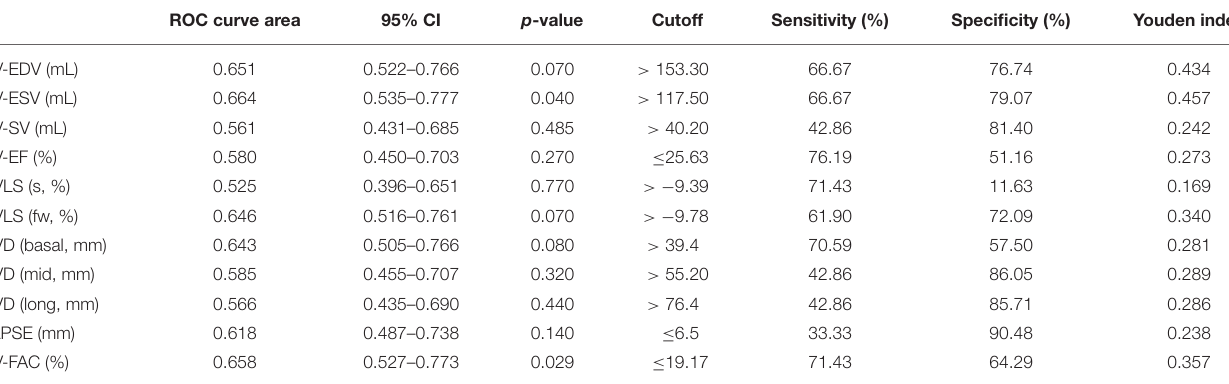
TABLE 5 | All PHTN cases ( n = 76) of 4D auto-RVQ areas of receiver operating characteristic (ROC) curves of various right ventricular function parameters. ROC curve